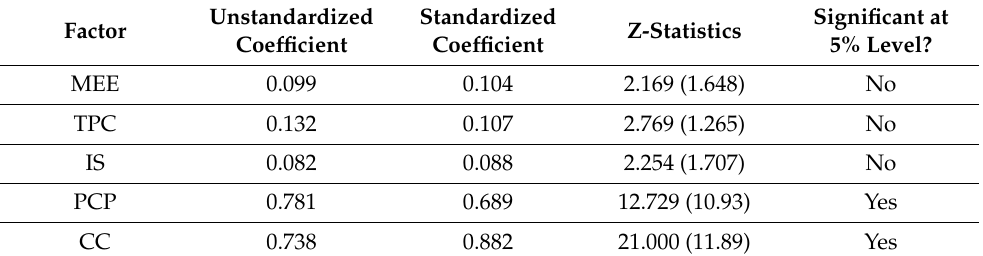
Table 14. Model 1.0 Factor loading and